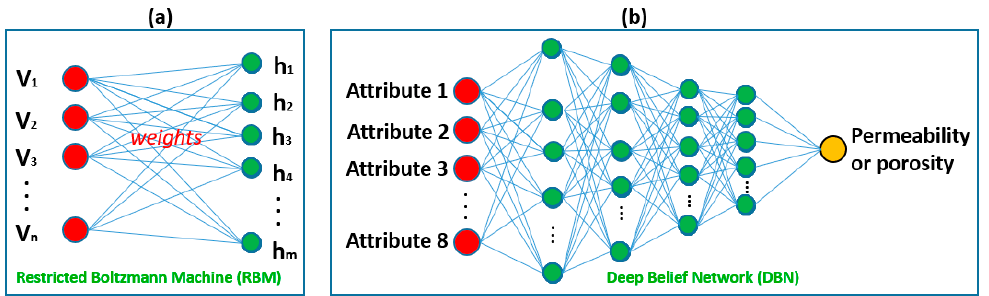
19 of 27 Figure 15. Prediction error versus the number of trees for statistical ensembles in the studied un- conventional coal reservoir. 4.2. Deep Learning and Deep Belief Network Deep learning is rather the latest achievement of artificial intelligence and machine learning that has captured the imagination of countless scientists and researchers. Deep learning refers to the in-depth feature engineering through successive layers of neural networks for increasingly meaningful representations of the data [54]. Deep herein doesn’t mean any kind of deeper understanding of the data, but it rather means the larger number of the functioning layers. A deep learning network consists of an input layer, sev- eral hidden layers, and an output layer. Deep architectures would be constructed by stacking autoencoders or by using deep belief networks (DBNs) [55]. DBN is the most effective technique among all deep learning models and is the technique of stacking many individual unsupervised networks that use each network’s hidden layer as the input for the next layer. The DBN implemented in the present study stacked restricted Boltzmann machines (RBM) in the hidden layers. The deep hierarchy of a DBF transforms the input features into nonlinear higher-level abstractions to extract more significant patterns and follow the trends in the input space [56]. These layers are first trained in an unsupervised manner. The structure of our adopted DBN consisted of four hidden layers with the sizes of 200, 100, 50, and 25 nodes, with eight input neurons (seismic attributes) and one output